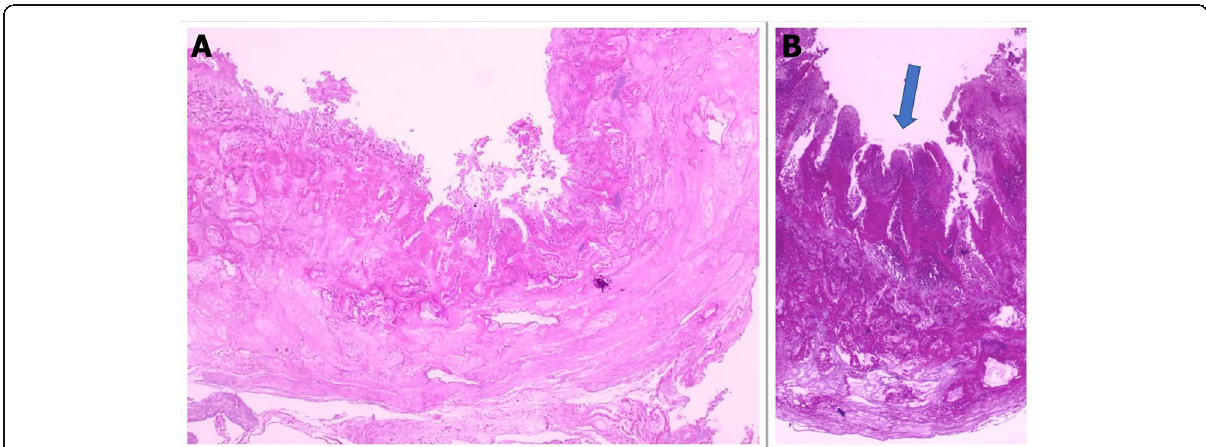
Fig. 4 Microscopic images showing acute-type extensive full-thickness (transmural) ischemic necrosis of the bowel wall. No viable area was observed on histology. Note the ghost-like outline of the previous small bowel villi (arrow). H&E stain. A ×20 and B ×40